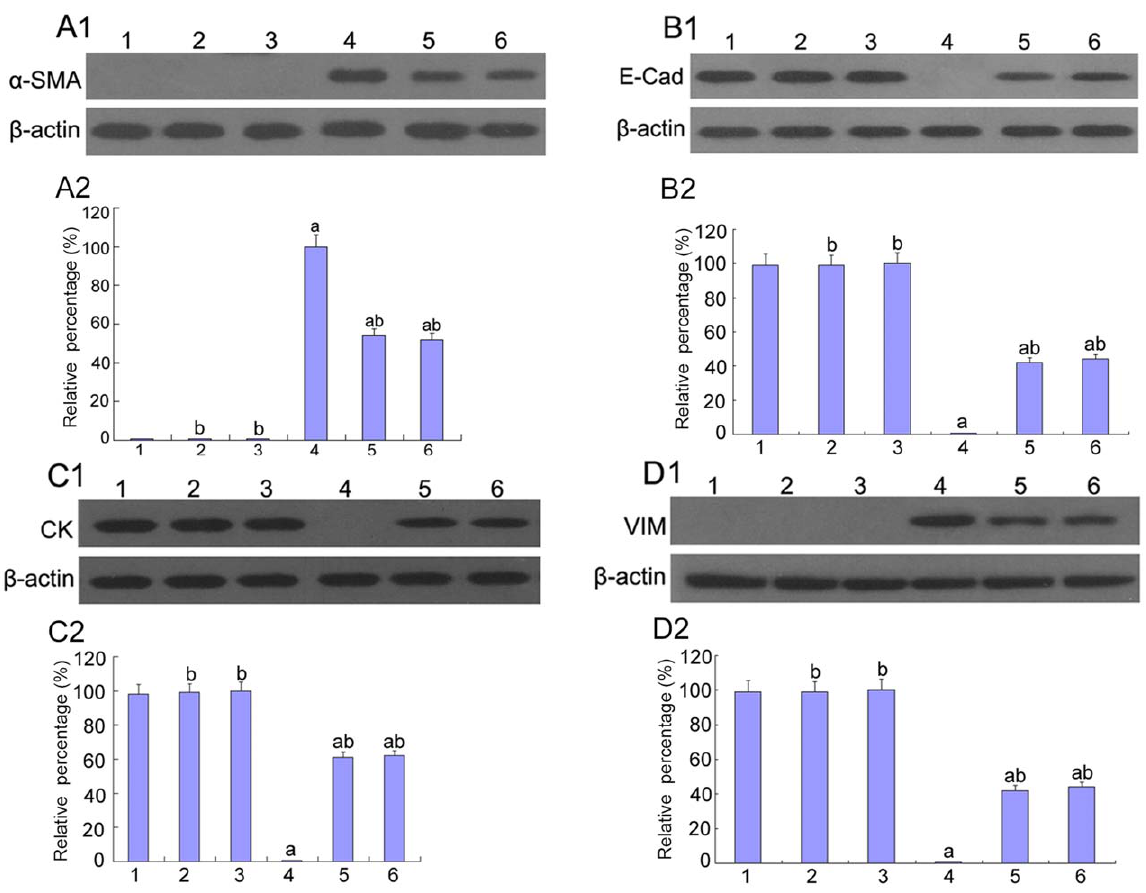
Figure 8. Expression of E-cadherin, CK, a -SMA, vimentin in HK-2 cells by Western blot. (A) a -SMA, (B)E-caderin, (C)CK, (D)vimentin were measured by Western blot of the HK-2 cells cultured in 5.5 mM glucose (lane 1), 5.5 mM glucose with p38 siRNA (lane 2), 5.5 mM glucose with AP-1 inhibitor (lane 3), 5.5 mM glucose + TGF- b 1 (10 ng/ml) (lane 4), 5.5 mM glucose + TGF- b 1(10 ng/ml) with p38 siRNA (lane 5), 5.5 mM glucose + TGF- b 1(10 ng/ml) with the AP-1 inhibitor (lane 6). a P , 0.05 vs. 5.5 mM glucose, b P , 0.05 vs. 5.5 mM glucose + TGF- b 1.